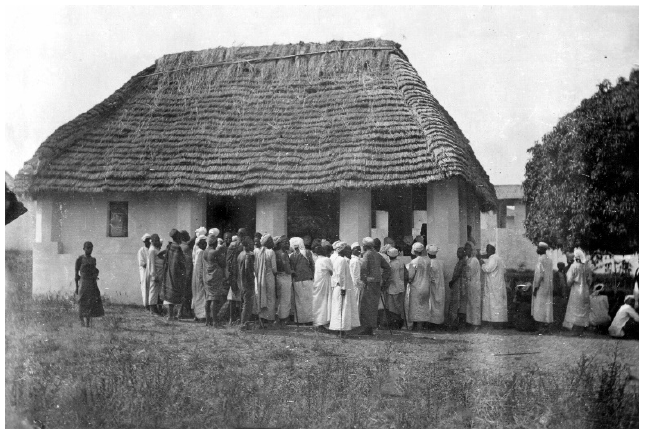
Figure 2. (Bayer Archive. 1921. (Picture 0-34295)) Screening of local population for symptoms of African sleeping sickness in the Urambi camp at Lake Tanganyika in 1921.